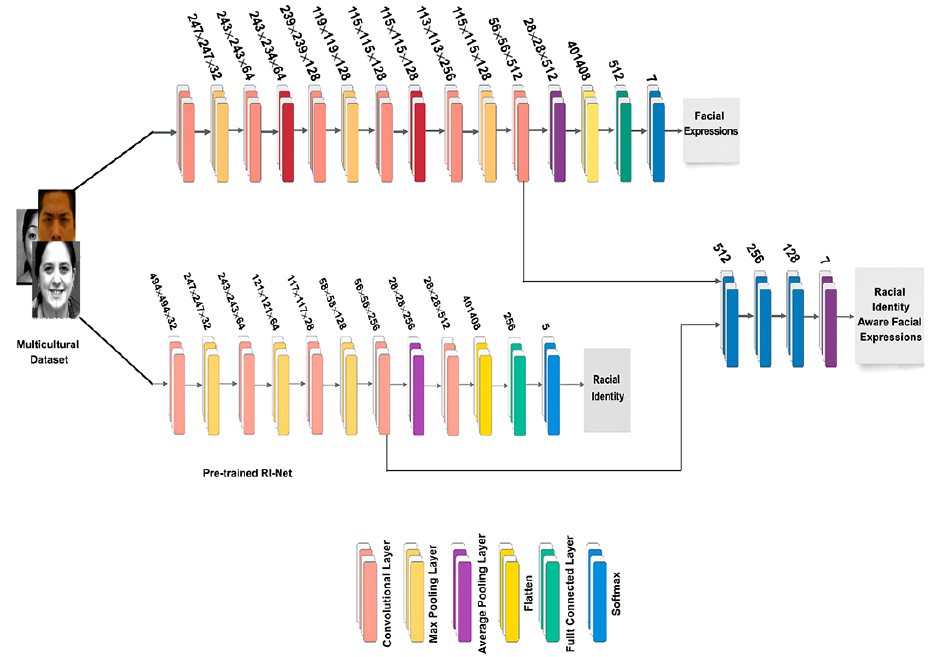
Figure 4. The proposed racial identity aware deep convolutional neural network (RIA-DCNN)